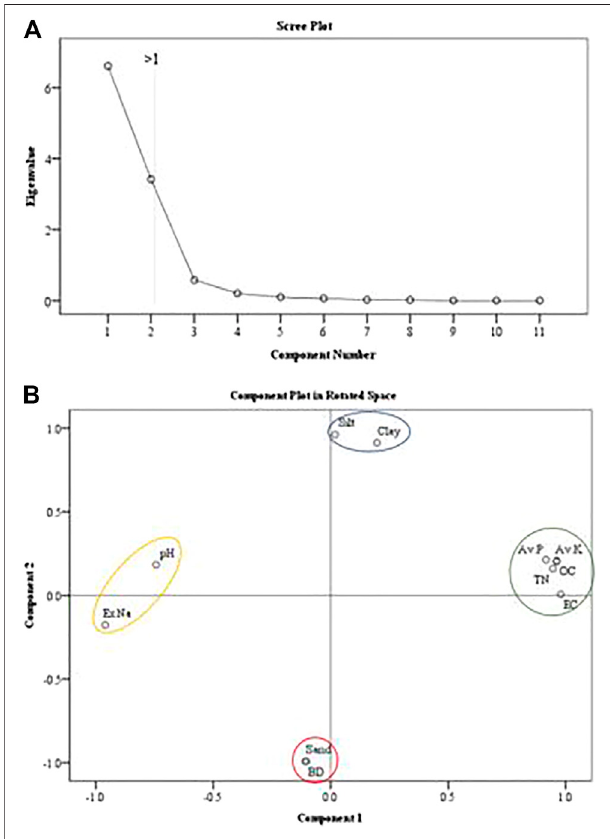
FIGURE 7 | (A) Scree plot for the different components considered for the principal component analysis with eigenvalues greater than one and (B) principal component analysis (PCA) of the overall data set. OC, organic carbon; TN, total nitrogen; Av. p, available phosphorus; Av. K, available potassium; Ex. Na, exchangble sodium; BD, bulk density; EC, electrical conductivity.